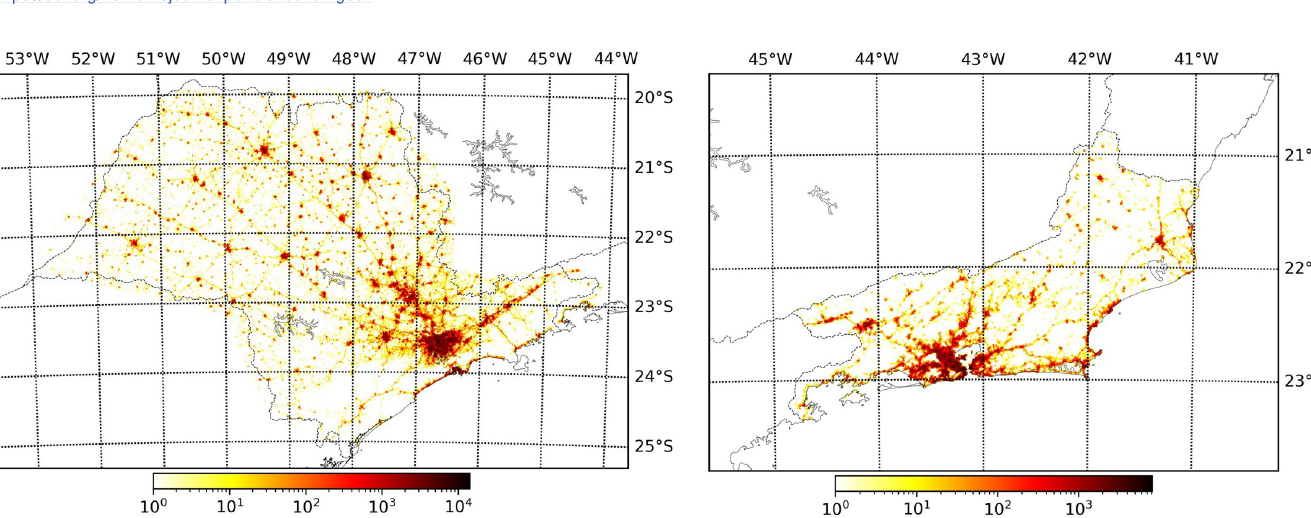
PLOS ONE | https://doi.org/10.1371/journal.pone.0235732 July 16, 2020 6 /